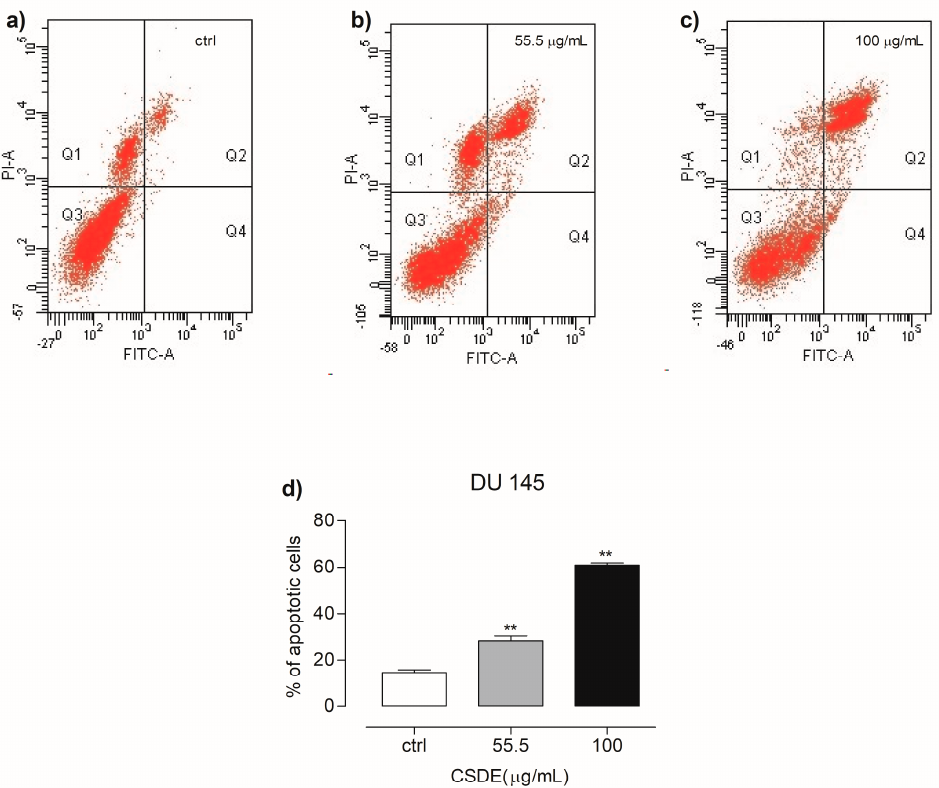
Figure 2. Representative dot plots showing cells in necrosis (Q1), late apoptosis (Q2), live cells (Q3), and early apoptosis (Q4), for control ( a ), 55.5 µ g / mL ( b ) and 100 µ g / mL ( c ), upon exposure with CSDE for 24 h. ( d ) Graph shows the number of cells undergoing both early and late apoptosis. Details are described in the materials and methods section. Each bar represents the mean ± SD of three independent experiments. ** p < 0.01 vs. control (untreated cells).